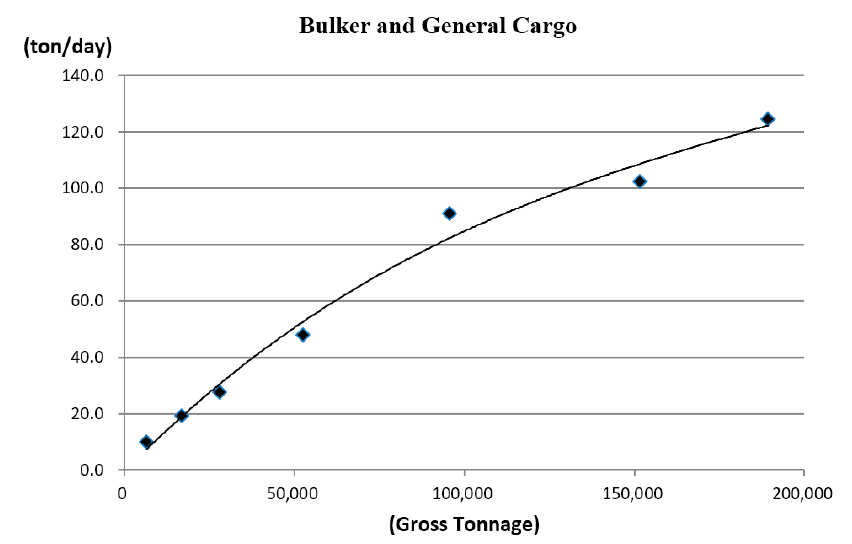
Figure 3. Daily LNG Fuel Consumption of Bulker and General Cargo.